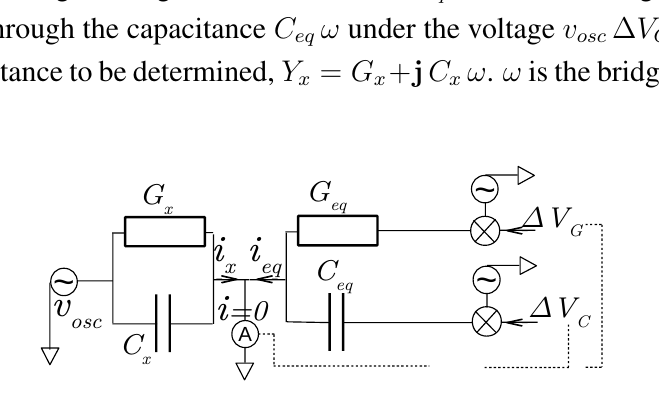
Figure 3. Schematic view of an ideal admittance bridge. When in balance, the current i generated by the bridge through the conductance G multiplier) and through the capacitance C